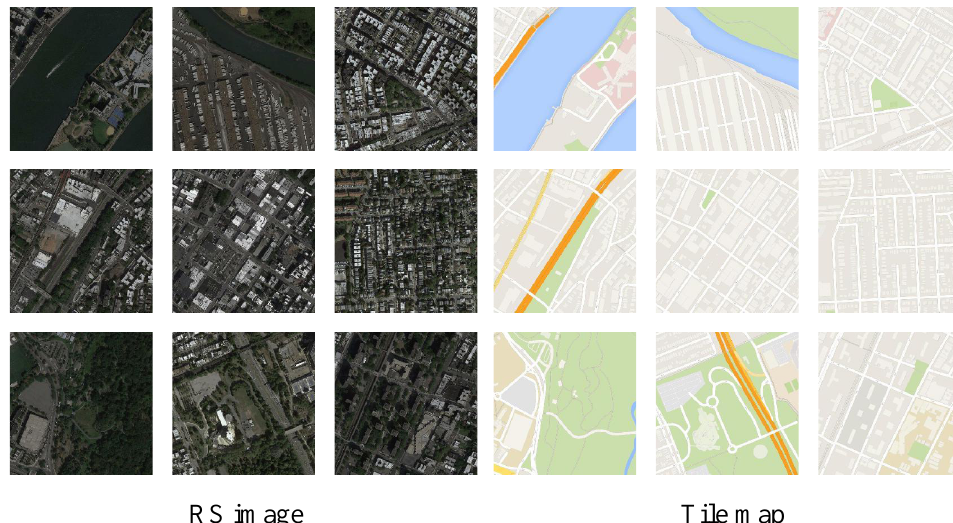
Figure 2. Examples from the maps